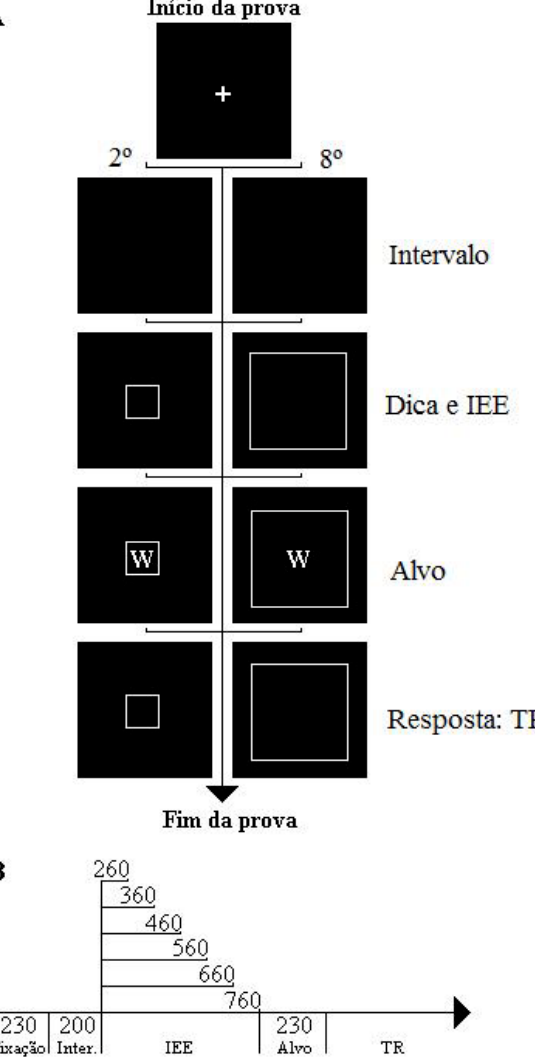
Figura 1. A- Representação esquemática dos estímulos apre- sentados no Experimento 1. A representação mostra a seqüência de eventos em cada prova (dicas: 2 ou 8 graus de ângulo visual). B- Seqüência temporal (ms) de eventos em cada prova do